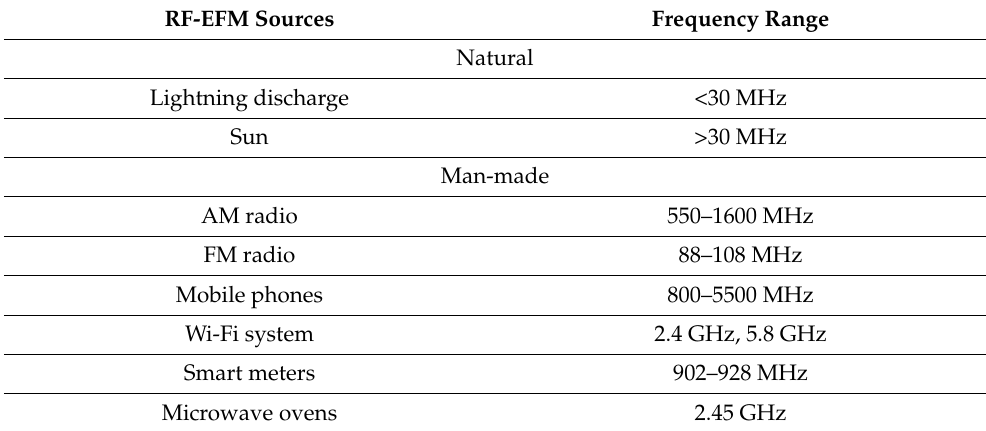
Table 1. Frequency ranges radiated by natural and manmade RF-EMF sources